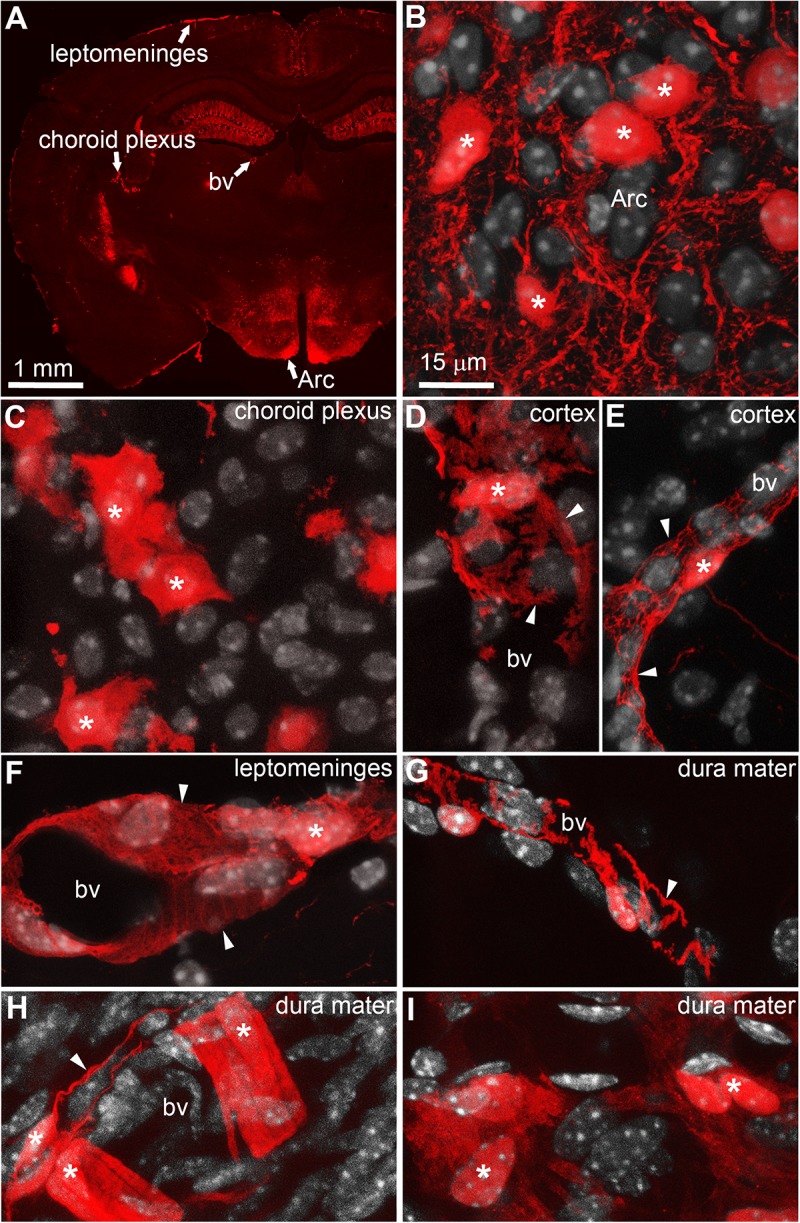
Distribution of intracranial tdTomato-labeled cells in the LepRb-Cre-tdTomato mouse. (A) Brain section at the level of the hypothalamus. Bright native fluorescence can be observed across the mouse brain in both the gray matter and structure outside the blood-brain barrier including the leptomeninges, and choroid plexus and isolated blood vessels. (B) Representative tdTomato-labeled neurons located in the arcuate nucleus of the hypothalamus (asterisks). Please note somas surrounded by a dense network of passing axons. (C) The choroid plexus containing clusters of tdTomato-labeled cells following the distribution and shape of epithelial cells (asterisks). (D,E) Representative tdTomato-labeled cells with a “bump-on-a-log” morphology in the cortex (asterisks). The latter cells are typically sparse with digitized processes wrapping around small blood vessels (arrows). (F–H) The leptomeninges and dura mater contained dense populations of cells in a perivascular position (asterisks). Despite the varied size and shape of their processes (arrows), most meningeal tdTomato-labeled cells in size resembled mural cells known as pericytes. (I) Occasionally, clusters of tdTomato-labeled cells resembling fibroblasts were seen in the dura matter. DAPI was converted to gray to enhance its visibility. Scale bar in (B) applies through (I). Arc, arcuate nucleus; bv, blood vessel.